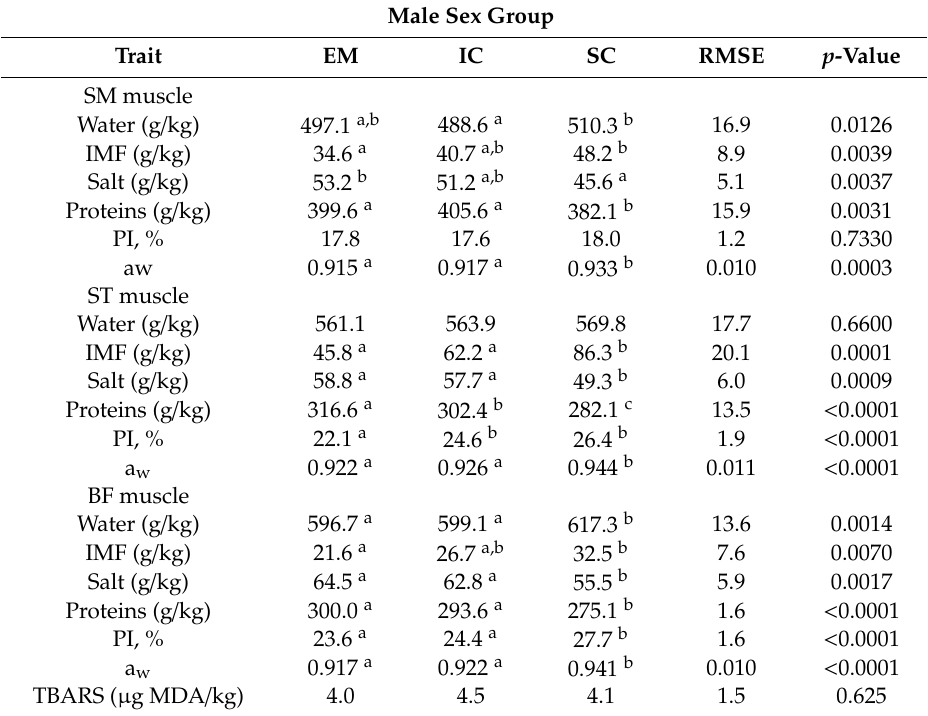
Table 2. E ff ect of male sex group on physical-chemical properties of dry-cured ham muscles. Male Sex